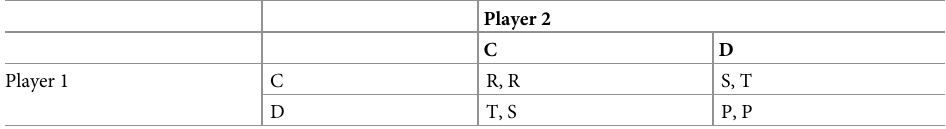
Table 1. Payoff matrix of a Prisoner’s Dilemma (PD)